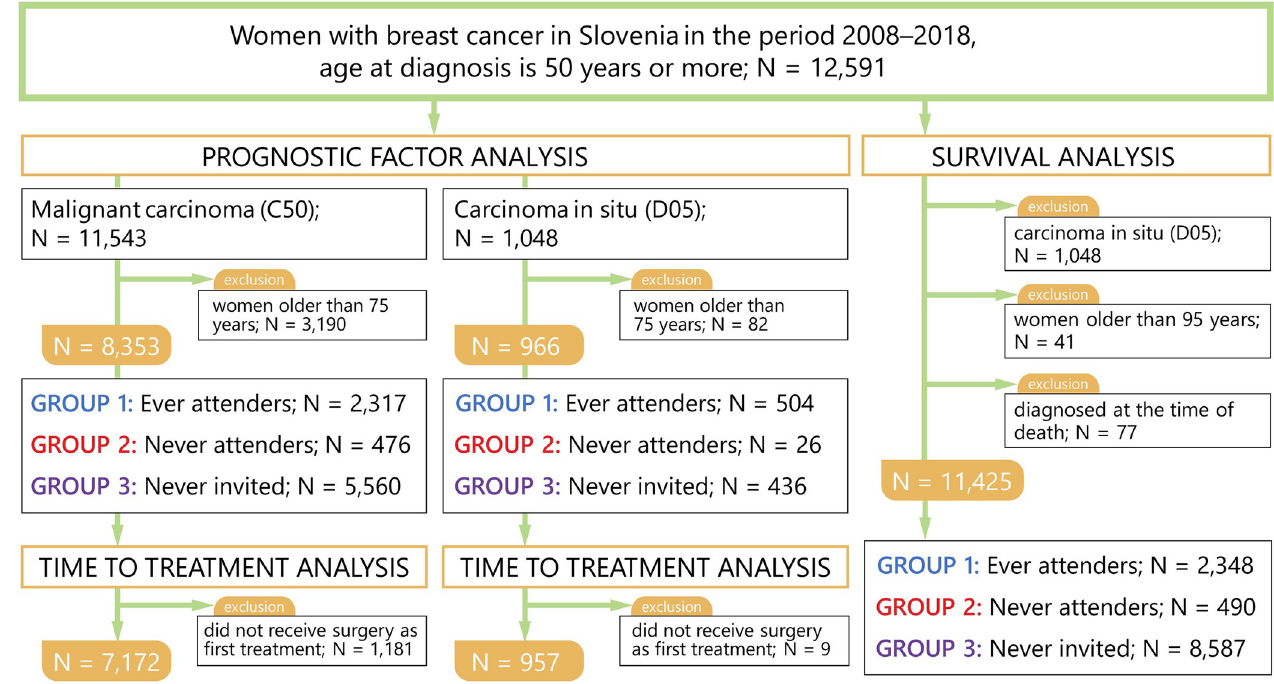
Fig 1. Inclusion and exclusion criteria. N = number of cases. 1 At least one mammography screening in organized screeningn programme prior to diagnosis. 2 At least one invitation to screening programme, but no screening performed. 3 No history of invitation or mammography within the screening programme.